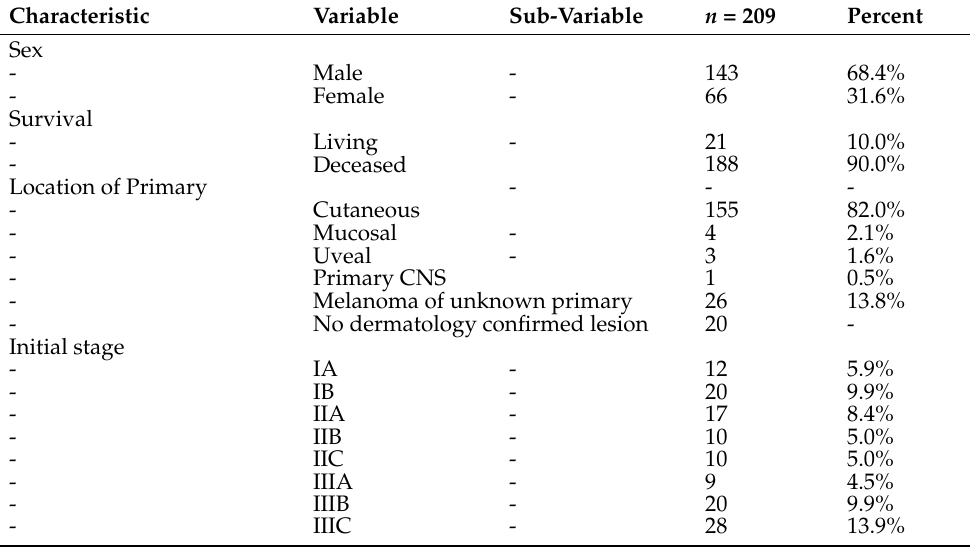
Table 1. Baseline characteristics of patients with brain